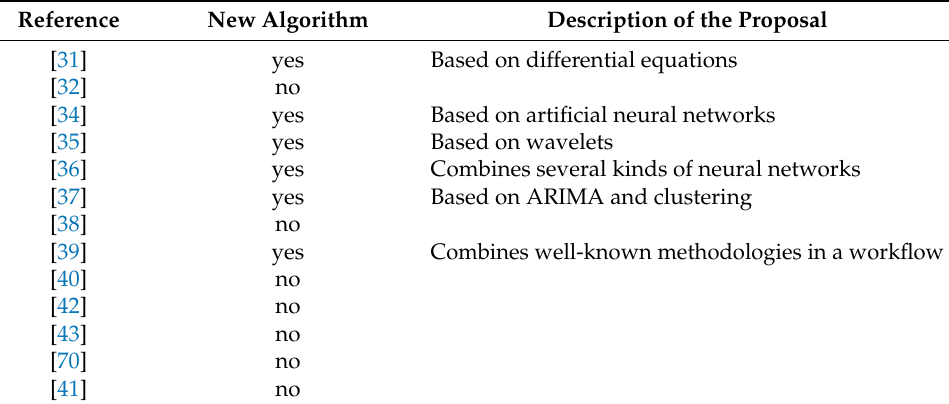
Table 6. List of papers that propose a new algorithm and a short description of their proposals.